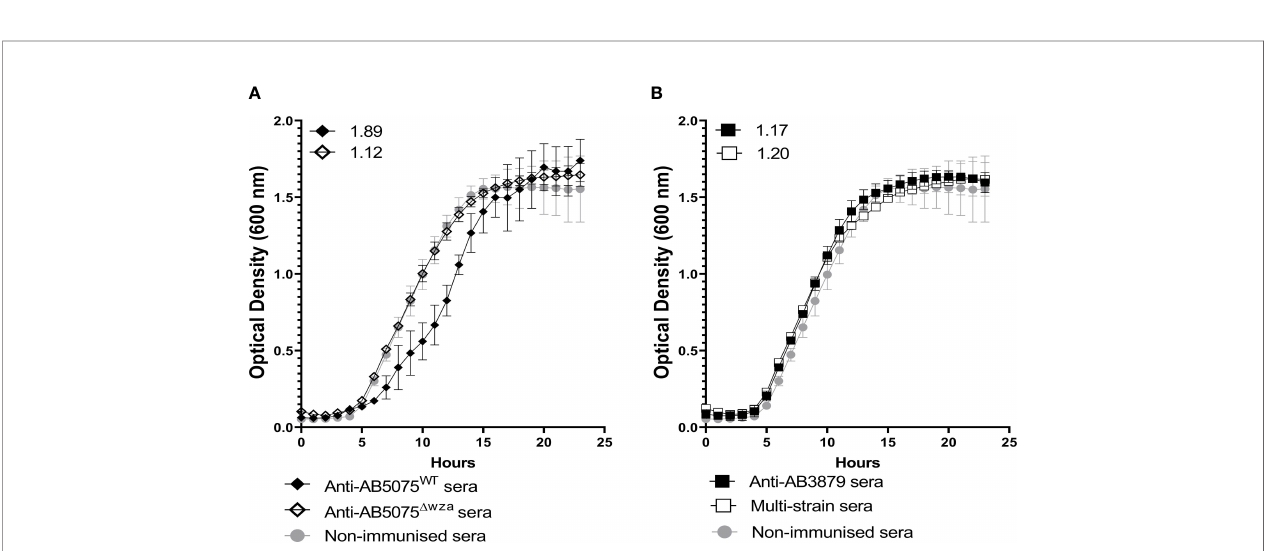
FIGURE 5 | Growth inhibitory activity of wild type AB5075 isolates by mouse antisera. 10 2 CFU of encapsulated AB5075 WT strain was incubated with either, AB5075 WT antisera (black line, solid diamond), AB5075 D wza antisera (black line, open diamond) and sera from non-immunized mice (grey line, solid circle) (A) or AB3879 antisera (black line, solid square), multi strain antisera (black line, open square), and sera from non-immunized mice (grey line, solid circle) (B) . Numbers on the top left corner represent the ratios of doubling time for respective antisera. Ratios of doubling time in test sera/control sera were calculated with a ratio of > 1.2 indicating delayed growth in the antisera. Line graphs indicate the mean value, and the error bars indicate standard deviations (SDs) (n=6).